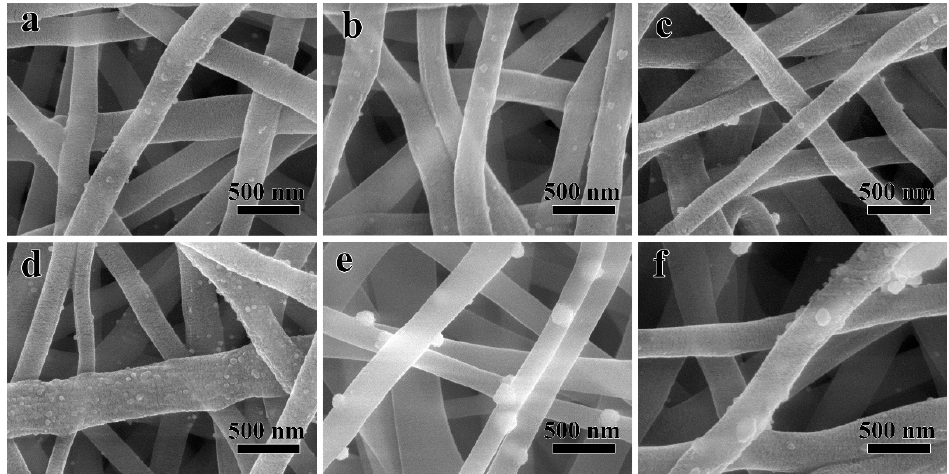
Figure 3. SEM images of Ag/PVA CNFs prepared with various concentrations of AgNO 3 , ( a ) 0.016, ( b ) 0.033, ( c ) 0.049, ( d ) 0.066, ( e ) 0.098 and ( f ) 0.132 mol/L.